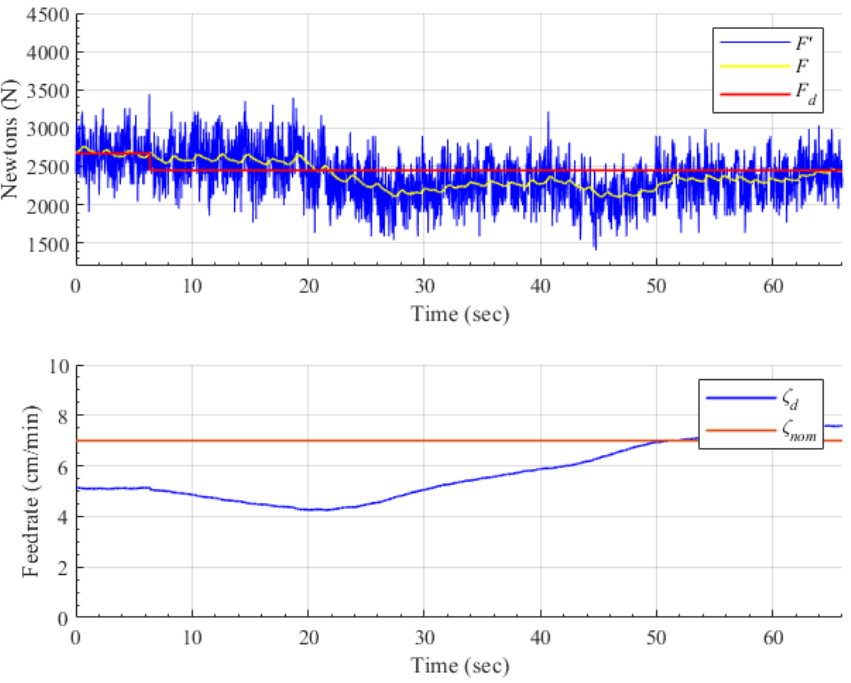
Figure 9. Protocol B. ( Top ) The desired versus measured force. The desired force was decreased at t ≈ 7 s. A maximum error of 350.1 N in the filtered force data occurs at t ≈ 29 s. ( Bottom ) The desired and nominal